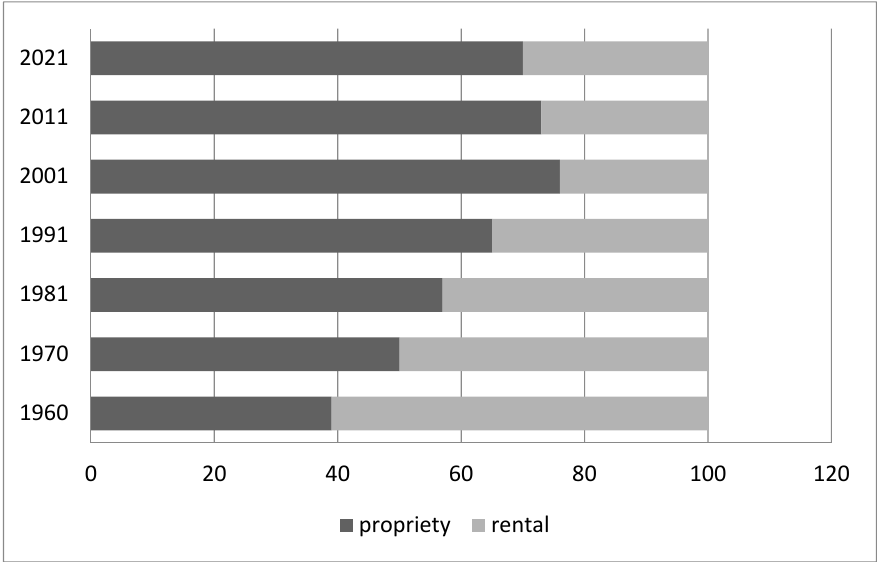
Figure 1. Houses by occupation regime: ownership and rental (1960–2021). Source: [17–23].